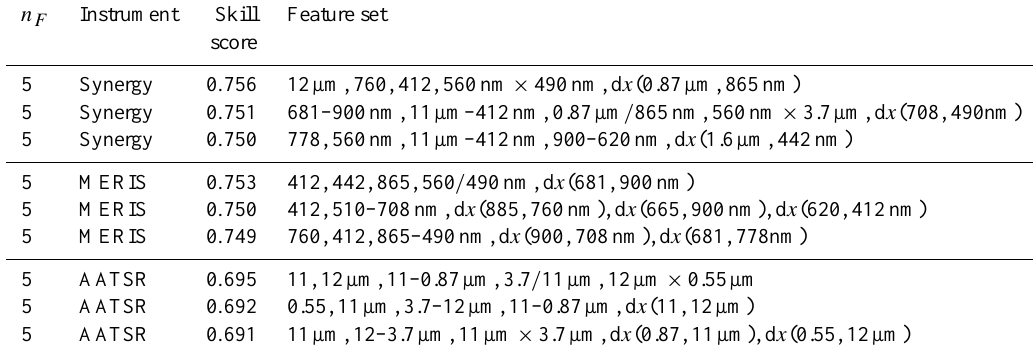
Table 3. Similar to Table 3 but for naive Bayesian cloud masks based on five strongly independent features. n F Instrument